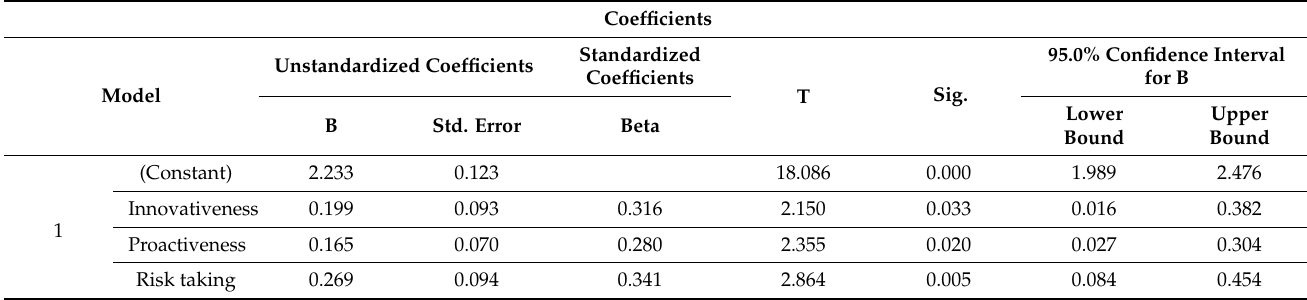
Table 11. Table coefficients.